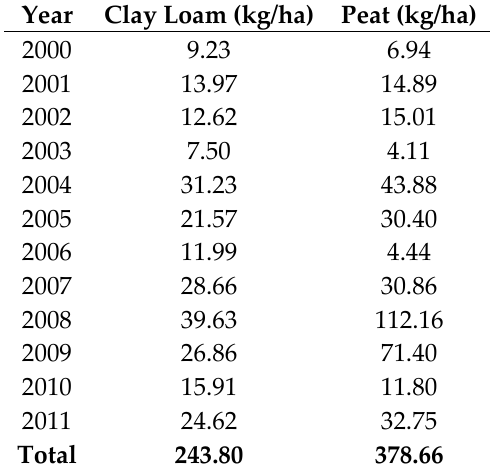
Table 2. Annual nitrogen load from different soil types for the Leivajõgi watershed. Clay Loam